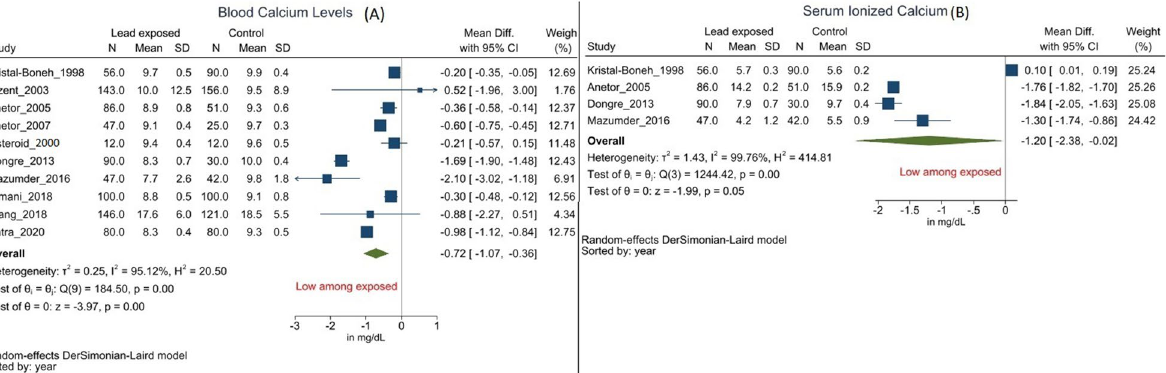
Figure 3. Forest plot for association between occupational Pb exposure and blood calcium levels. (Legends/ footnotes): forest plot revealing the group mean differences in serum calcium ( A ) and ionised calcium ( B ) levels in mg/dl between the occupationally Pb exposed workers and control participants. The square and whisker (horizontal lines) represent respectively the mean difference and 95% confidence interval of individual studies. The length and width of the diamond indicate respectively the pooled mean difference and 95% confidence interval derived from random-effect